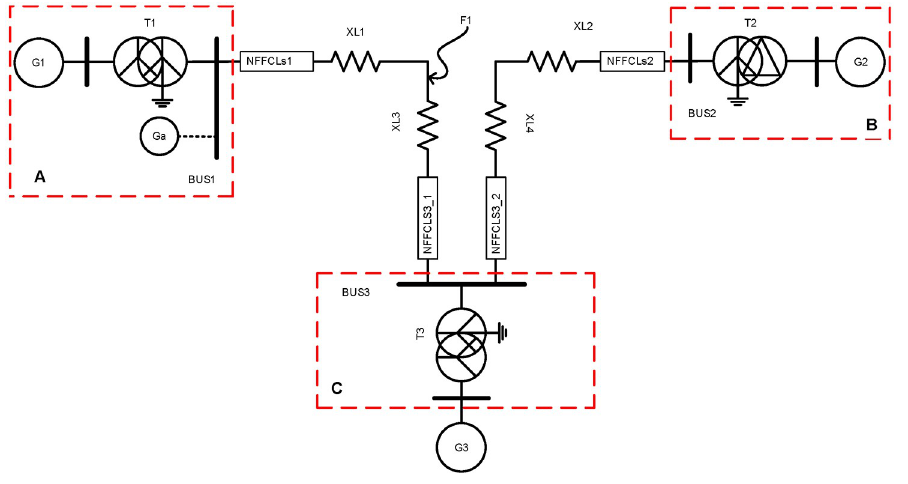
Fig 6. Multi-source distribution network schematic